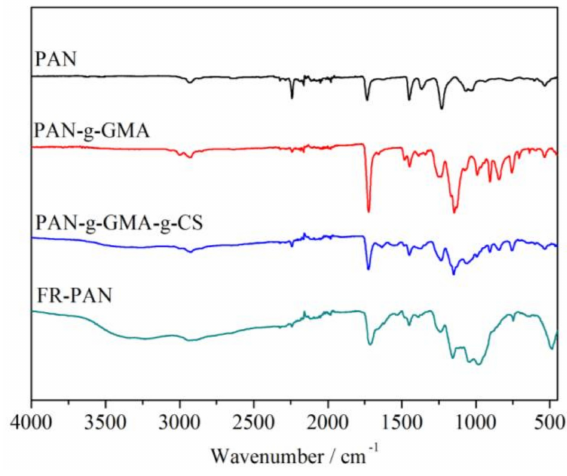
Figure 1. FTIR spectra of PAN and modified PAN